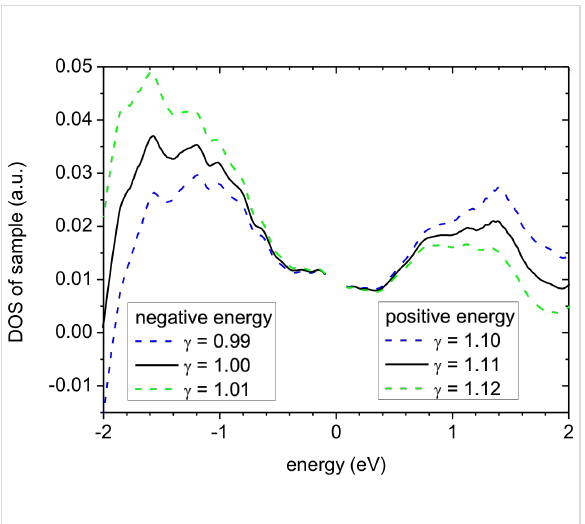
Figure 5: Influence of the parameter γ on the resulting experimental sample DOS. Three DOS are shown in the positive energy range for γ = 1.11 as in Figure 3a (black solid curve), γ = 1.10 (blue dashed), γ = 1.12 (green dashed) and in the negative energy range for γ = 1.00 as in Figure 3a (black solid curve), γ = 0.99 (blue dashed), γ = 1.01 (green dashed). Note that changing γ has an asymmetric influence on the DOS.